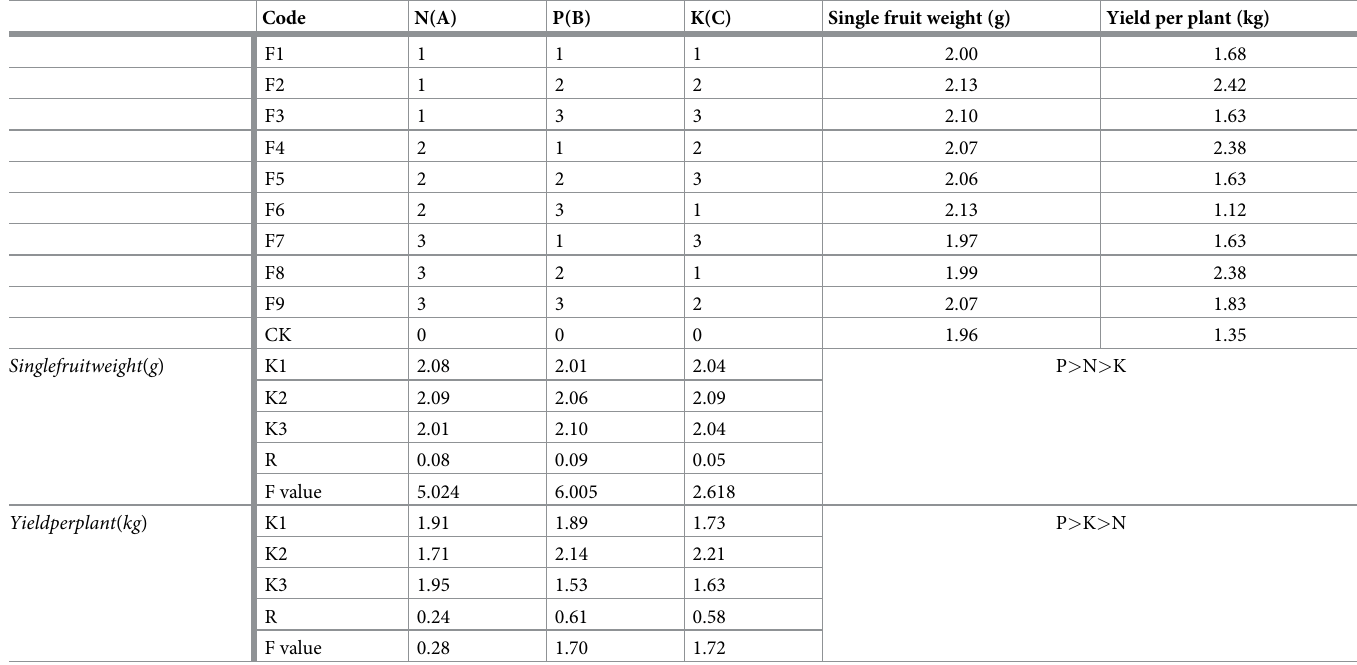
Table 3. Results and analysis of orthogonal experiment on fruit yield of